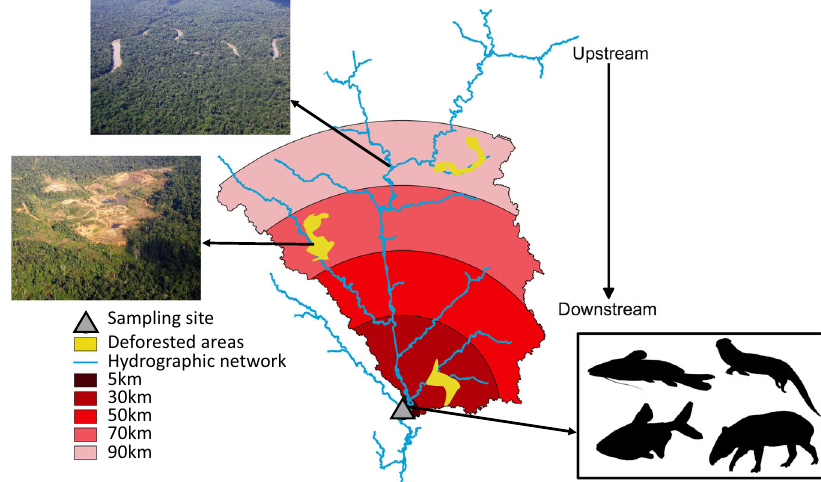
Fig. 1 Measurement of the percentage of deforestation upstream from each biodiversity sampling site. For clarity, only fi ve of the 14 spatial extents are illustrated here. Spatial extents are represented by the surface area of the river drainage basin between the biodiversity sampling site and 5, 30, 50, 70, and 90 km upstream from the site. River basin boundaries are indicated by black continuous lines. For each site, the percentage of deforested area for each spatial extent was calculated. For instance, a 30 km extent of disturbance measures the percentage of deforested area within the river basin from the biodiversity sampling site to a maximal distance of 30 km upstream from this